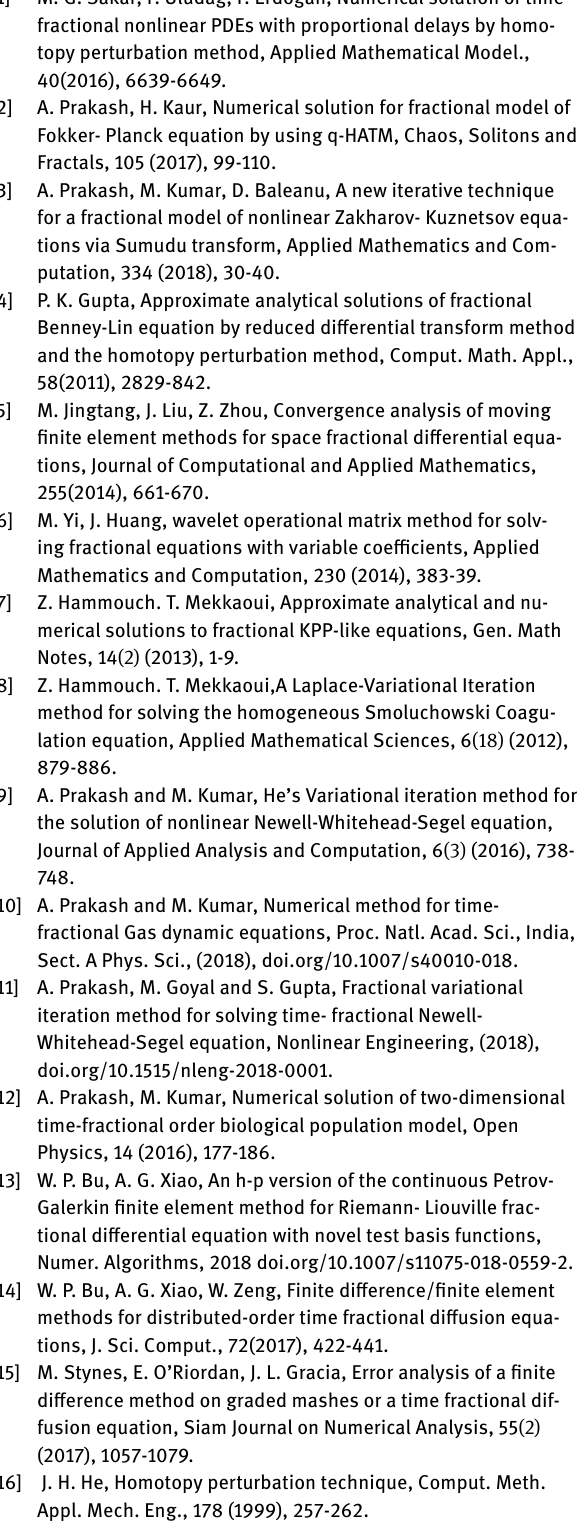
Table 4: Absolute errors for differences between the exact solution and 3 rd order HPTT solution for diverse values x and t when ρ = 0.45, β = 0.5, for Ex. 5.2